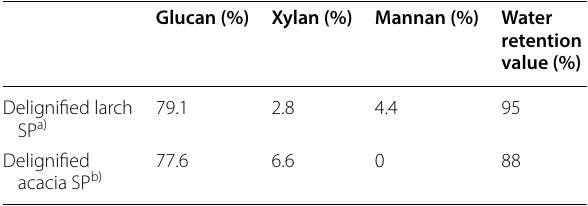
Table 4 Chemical composition and water retention value of delignified pulp